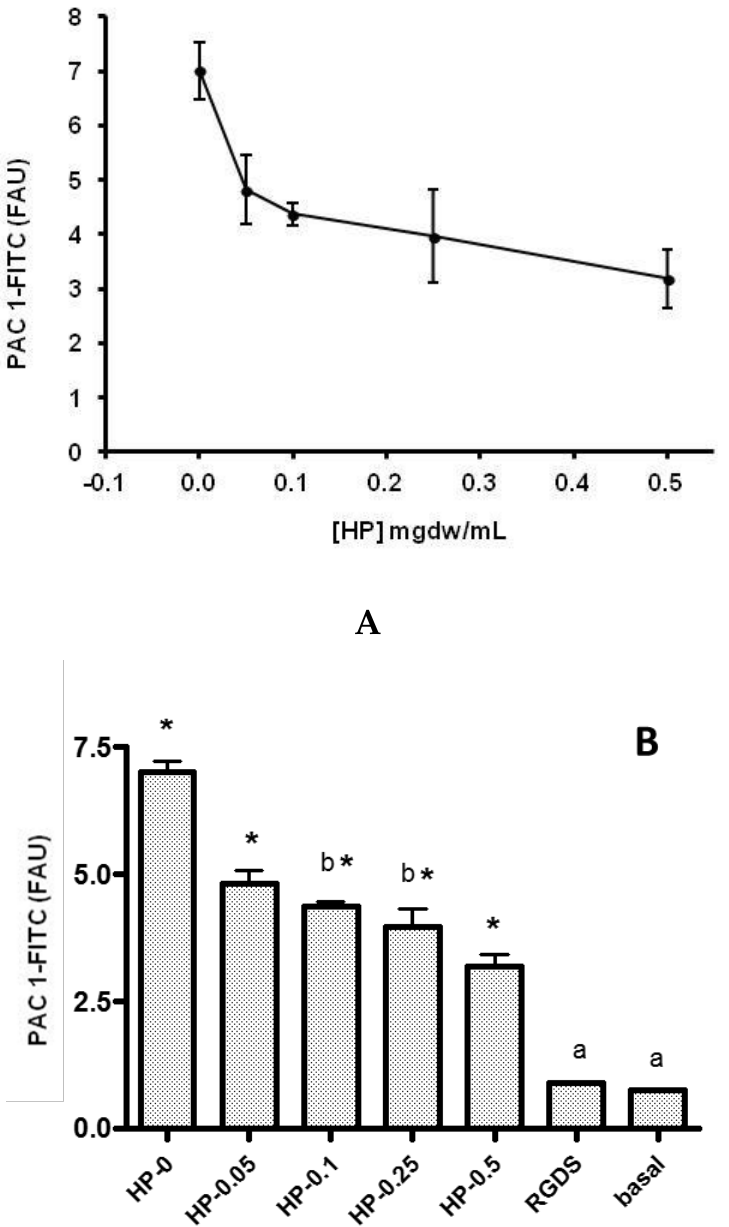
Figure 3. Effect of HP on thrombin-induced expression of activated GPIIbIIIa (0.05 U/mL) assessed by fluorescence intensity. Data are presented as mean+/ − SEM for three different experiments with the same donor. FAU: PAC1-FITC-fluorescence units in total platelet population (CD6+ events) ( A ). ( B ) Global HP effect and statistical comparison. All values obtained with HP are significantly different from those obtained without treatment (*), except those marked with the same letter (a and b).